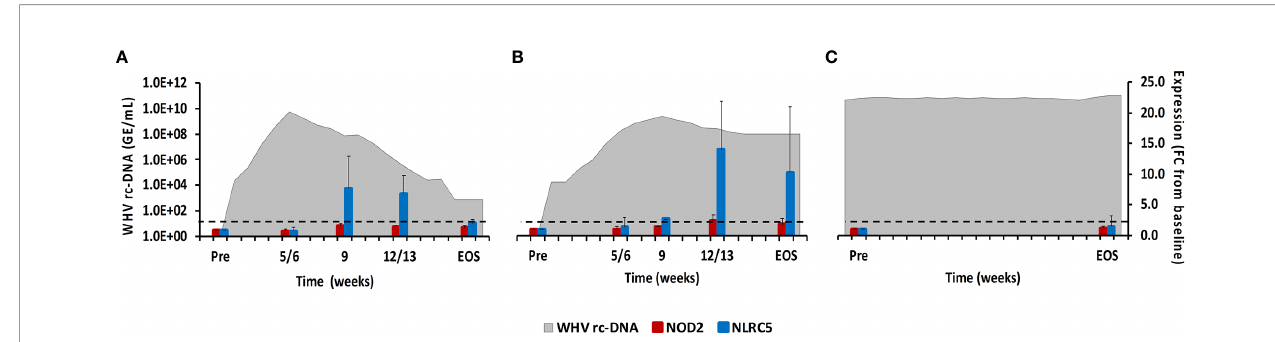
FIGURE 4 | Intrahepatic NLR expression. Expression changes of NOD2 and NLRC5 in liver with WHV rc-DNA kinetics of woodchucks during (A) AHB with normal resolution (n=5), (B) AHB with delayed resolution (n=5), and (C) CHB progression (n=3). The fold-changes in receptor transcript level are plotted on the right y-axis, while serum WHV rc-DNA loads are plotted on the left y-axis. The horizontal, dotted line indicates the cutoff for positive expression (i.e., ≥ 2.1-fold increase from the pre-inoculation baseline). Horizontal bars represent the standard error of the mean. Pre, pre-inoculation for AHB and start of study for CHB; EOS, end of study; FC,